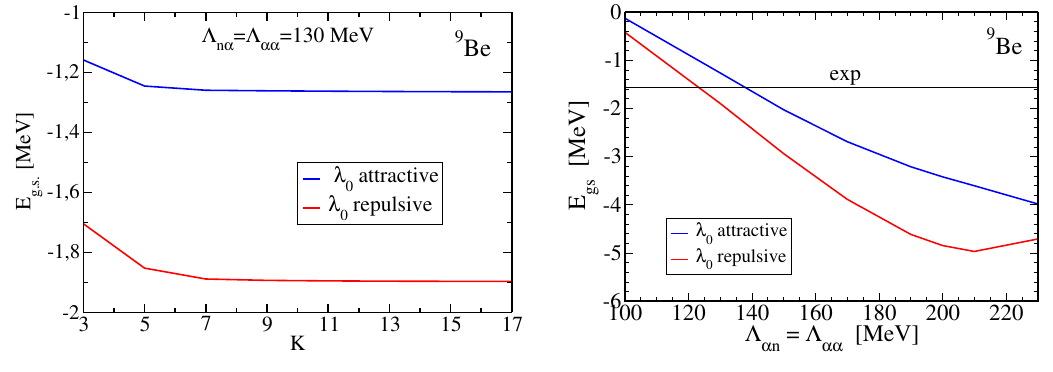
Figure 4: 9 Be ground state energy as a function of the cutoff. Here, we use the same value for Λ Λ α n and αα .